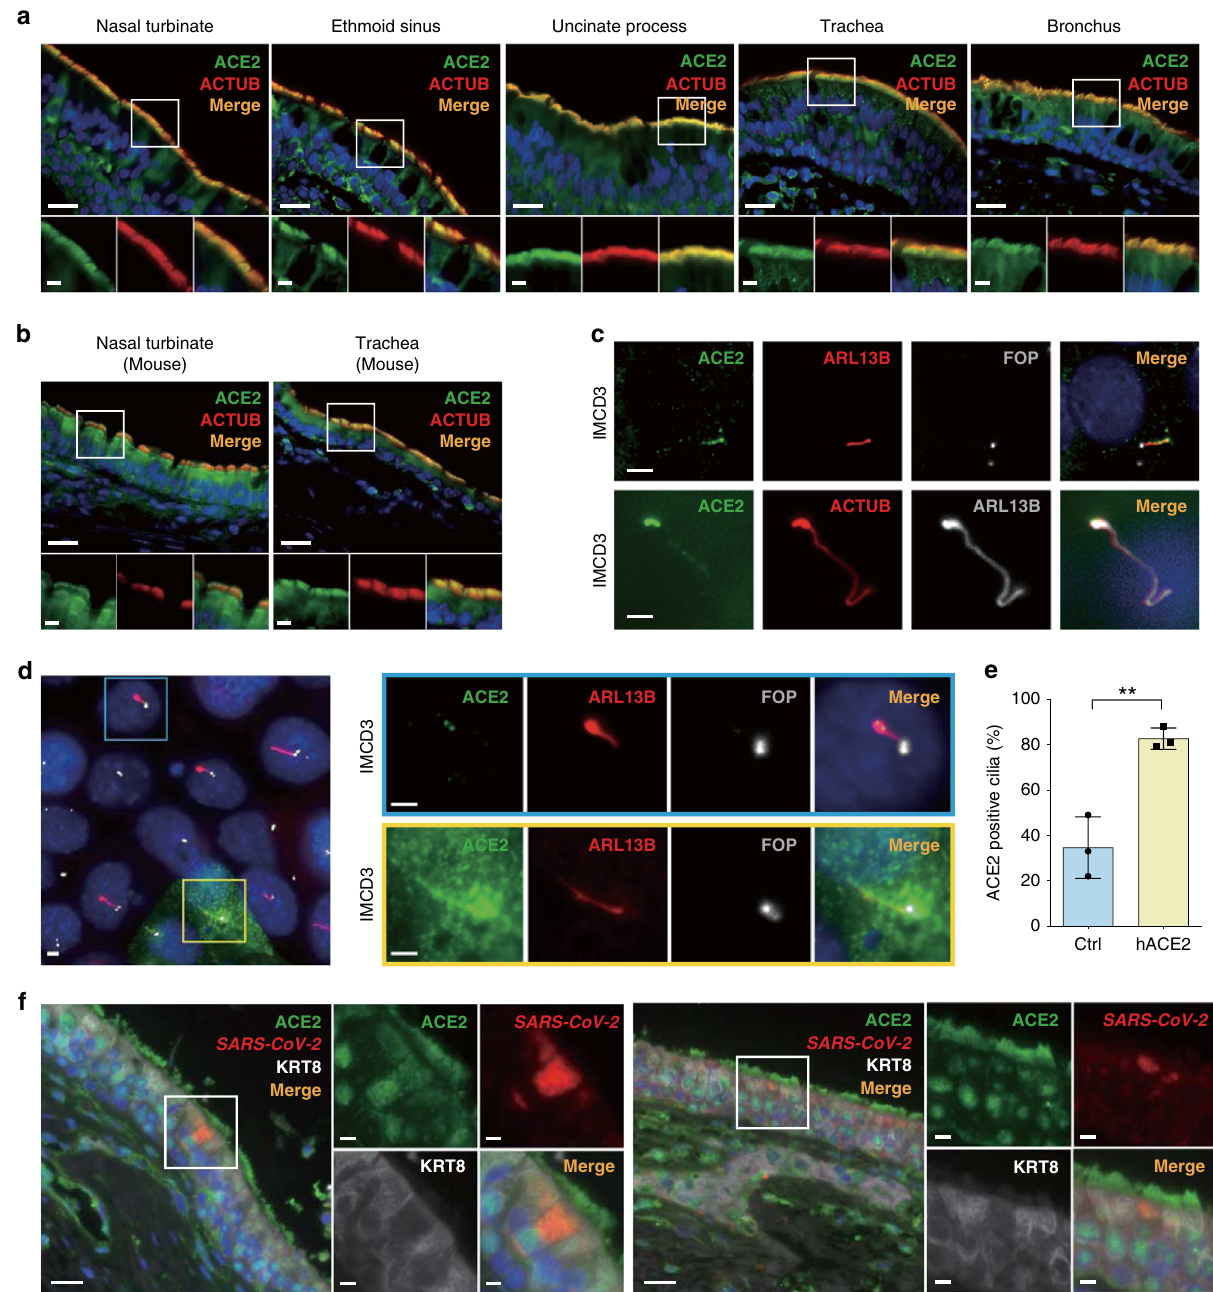
Fig. 3 ACE2 protein expression in the cilia organelle of upper and lower respiratory tract epithelia and in a ciliated kidney epithelial cell line. a Representative double immuno fl uorescence staining of ACE2 and acetylated α -tubulin (ACTUB) on normal human nasal turbinate, ethmoid sinus, uncinate process (sinus), trachea, and bronchus, using anti-ACE2 and anti-ACTUB antibodies, respectively. b Representative double immuno fl uorescence staining of ACE2 and ACTUB on normal C57BL/6J mouse nasal turbinate and trachea. c Immuno fl uorescent staining of (top panel) ACE2, cilia marker ADP- ribosylation factor-like protein 13B (ARL13B), and cilia centrosome marker FGFR1 oncogene partner (FOP); (bottom panel) ACE2, and cilia markers ACTUB and ARL13B in a ciliated mouse cell line, IMCD3. d Immuno fl uorescent staining of ACE2 in the primary cilia of IMCD3 cells transiently transfected with human ACE2 (yellow outline) compared to endogenous mouse ACE2 (blue outline). e Quanti fi ed percentages of endogenous ACE2-positive cilia (34.67 ± 13.58%; control (Ctrl)) versus cilia with overexpressed human ACE2 (82.67 ± 4.73%). Ciliated cells were identi fi ed by staining of ARL13B. Error bars represent mean ± SD. ( n = 100 cells examined per experiment over three independent experiments). (Two-tailed Student ’ s t test, ** p = 0.004). f Representative multiplexed images of in situ hybridization against the SARS-CoV-2 Spike mRNA, in combination with immuno fl uorescence staining of ACE2 and the differentiated epithelial cell marker cytokeratin 8 (KRT8). SARS-CoV-2 Spike mRNA expression (red) was detected within ciliated epithelial cells containing motile cilia positive for ACE2 (green). The nuclei were stained using DAPI (blue) as a counterstain. Scale bars: 20 μ m ( a , b top panels; f large panels); 5 μ m ( a , b bottom panels; f small panels); 2 μ m ( c , d